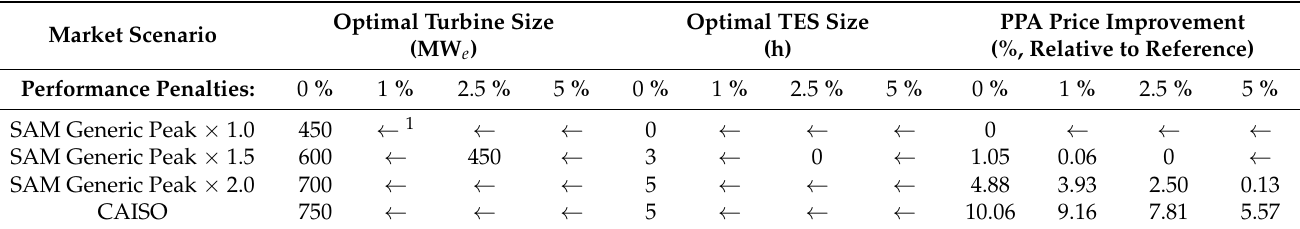
Table 5. Sensitivity of optimal design point to efficiency penalty incurred by implementing TES. PPA price improvements are calculated relative to reference design performance in the respective